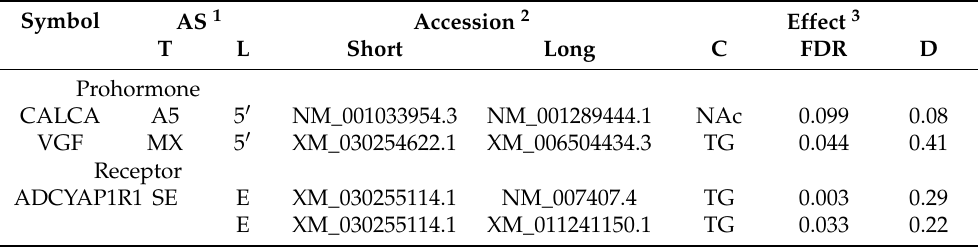
Table 5. Number of neuropeptide prohormone and receptor genes presenting significant (FDR- adjusted p -value < 0.1) alternative spliced events across treatments (NTG =